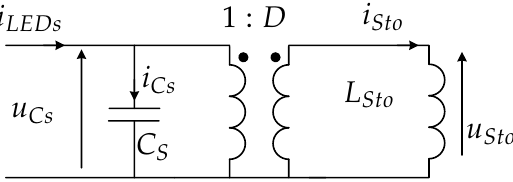
Figure 6. LF equivalent circuit of the proposed second stage converter.